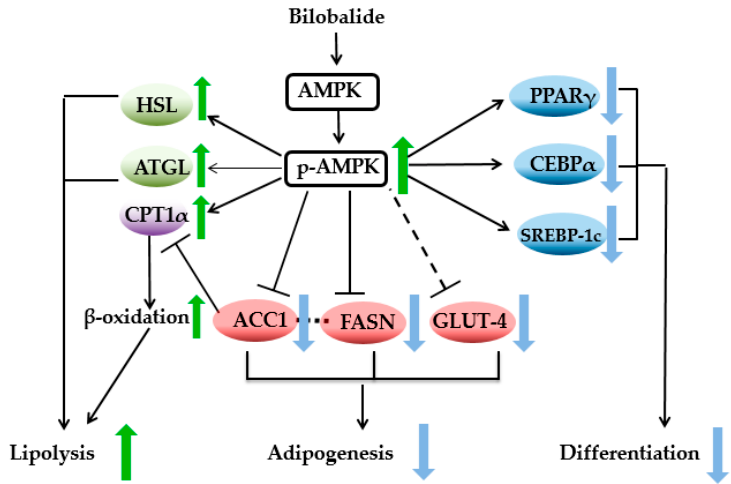
Figure 8. Schematic diagram showing the molecular mechanism of BB decreases lipid accumulation and inhibits obesity by down-regulating multiple transcription factors, inhibiting the synthesis of lipid accumulation proteins, and promoting the expression of lipid-degrading proteins in 3T3-L1 cells.